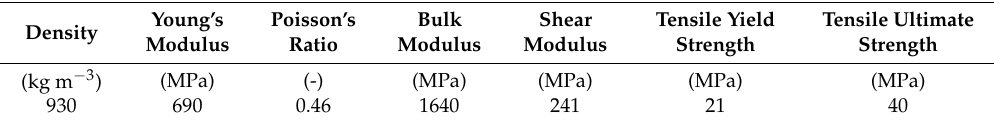
Table 1. UHMWPE GUR 1050 properties.